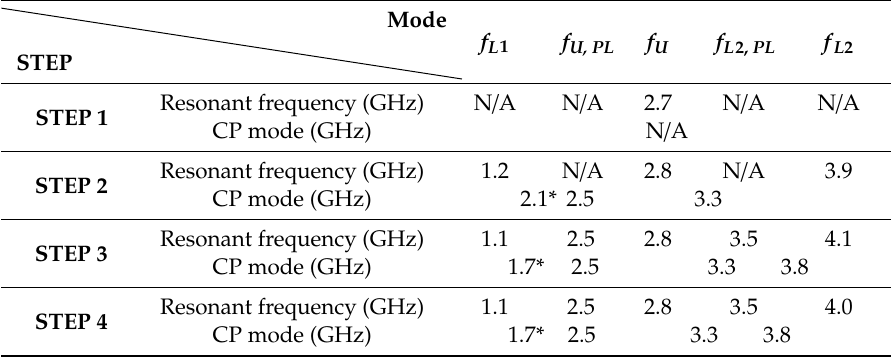
Table 1. CP mode generation from two orthogonal LP modes for each